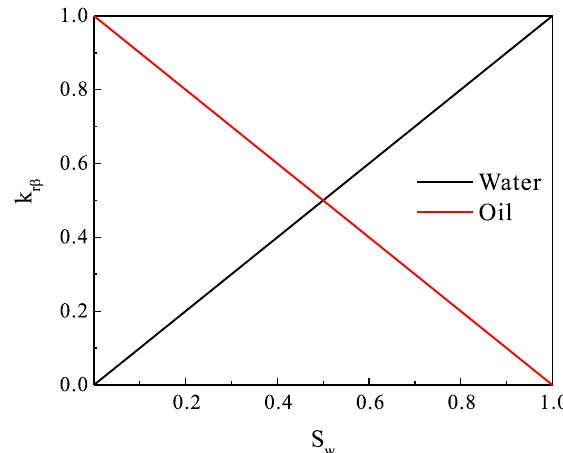
Figure 11. Relative permeability of the vug grids for numerical simulation.